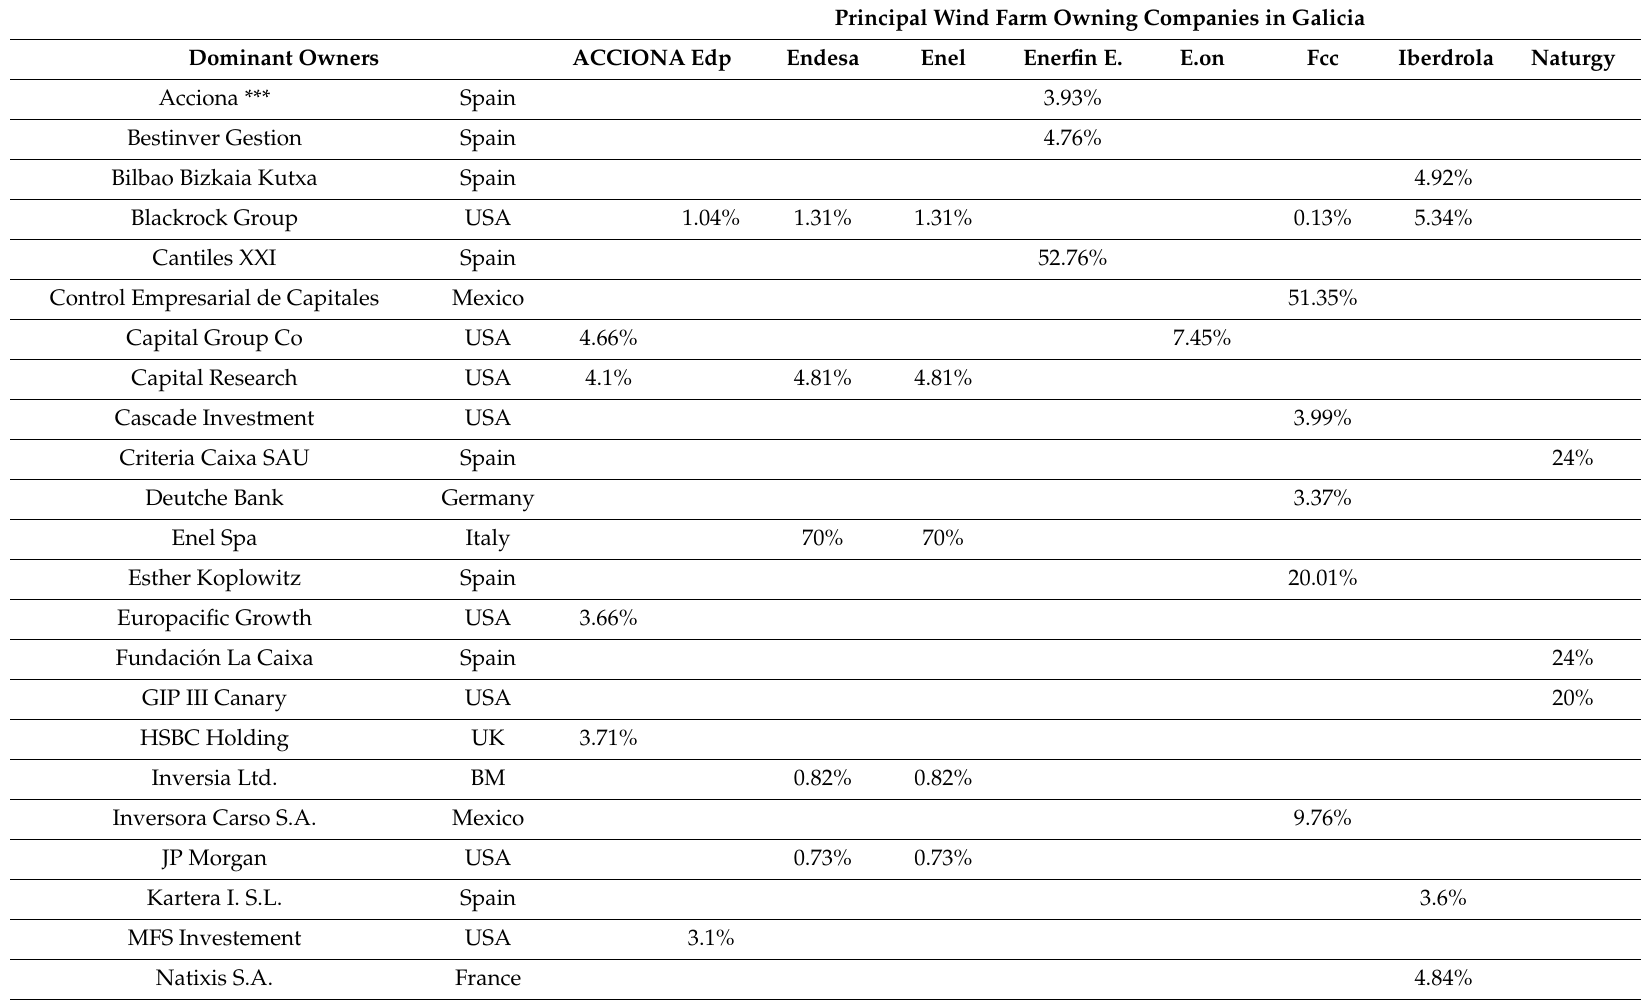
Table 5. Dominant owners and principal wind farm owning companies in Galicia (1995–2017) elaborated from Table 4,